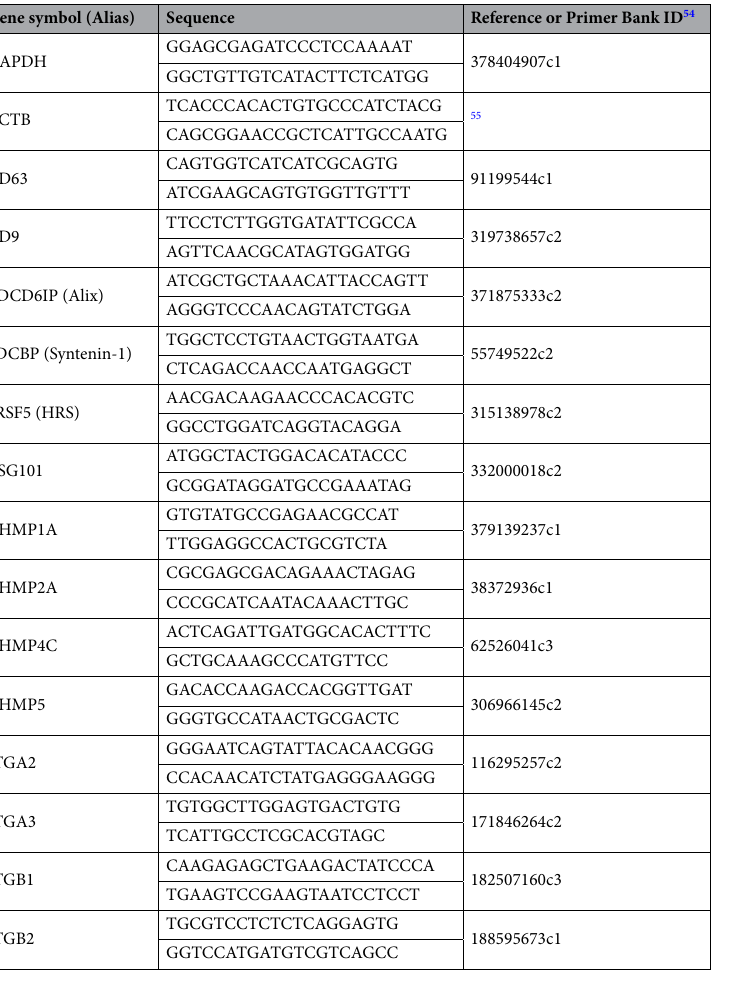
Table 5. Sequence of other qPCR